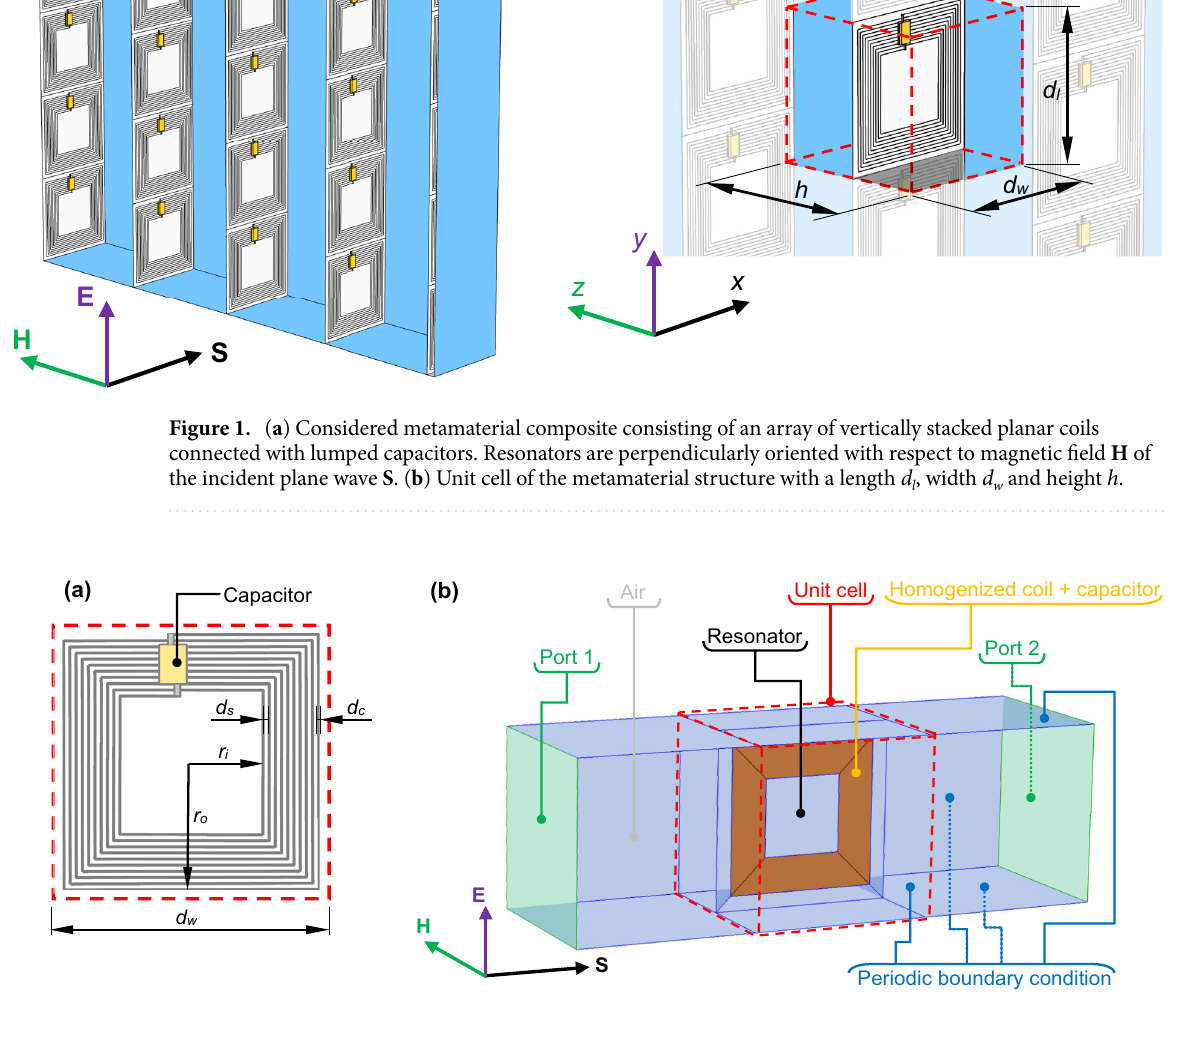
Figure 2. ( a ) A view on the resonator wounded using thin wires with diameter d c and separation d s . ( b ) The 3D numerical model of the metamaterial (unit cell) with boundary conditions and homogenized planar